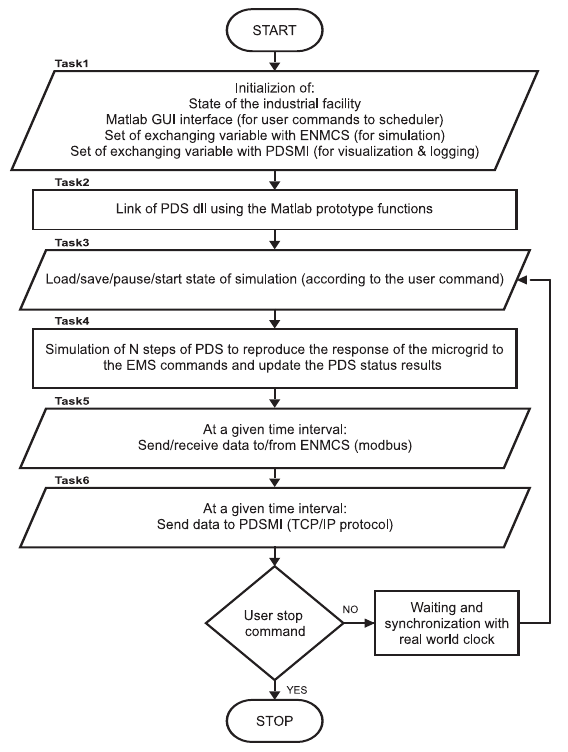
Figure 6. Flowchart of the MATLAB Runtime Scheduler (MRS). PDSMI, PDS monitoring